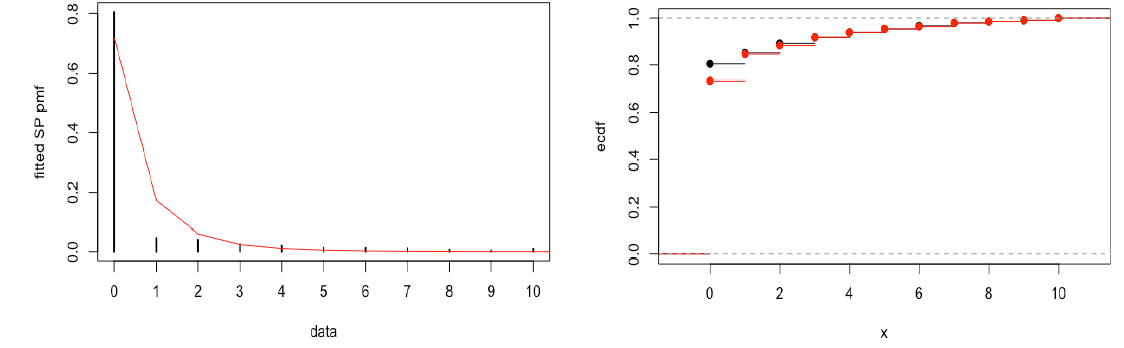
Figure 4. Fitted pmf plot ( left ) and ecdf plot ( right ) for the parasite intensity